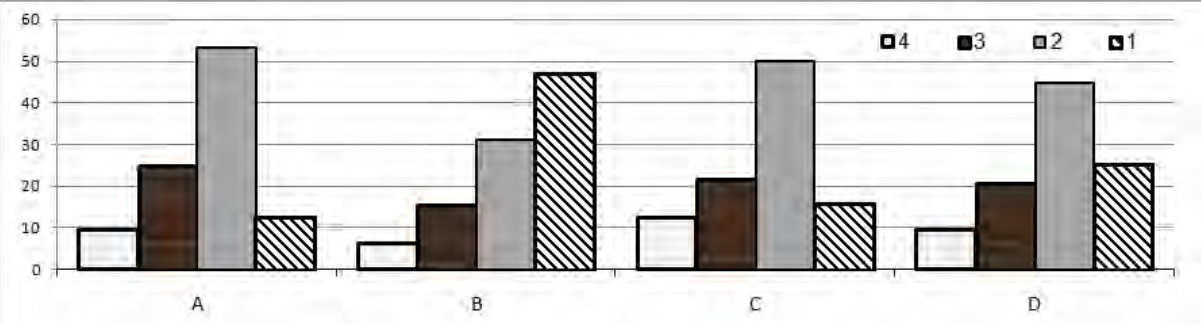
Fig.2. Relative indicators of applied motor skills formation in military officers (n = 32), where: % - Percentage of military officers, who fulfilled exercise; А – exercise: throw of grenade with ammunition; B – exercise: overcoming of wall of 1.1 meters with ammunition; C – exercise: self-insurance when falling on back; D – mean indicator of applied skills’